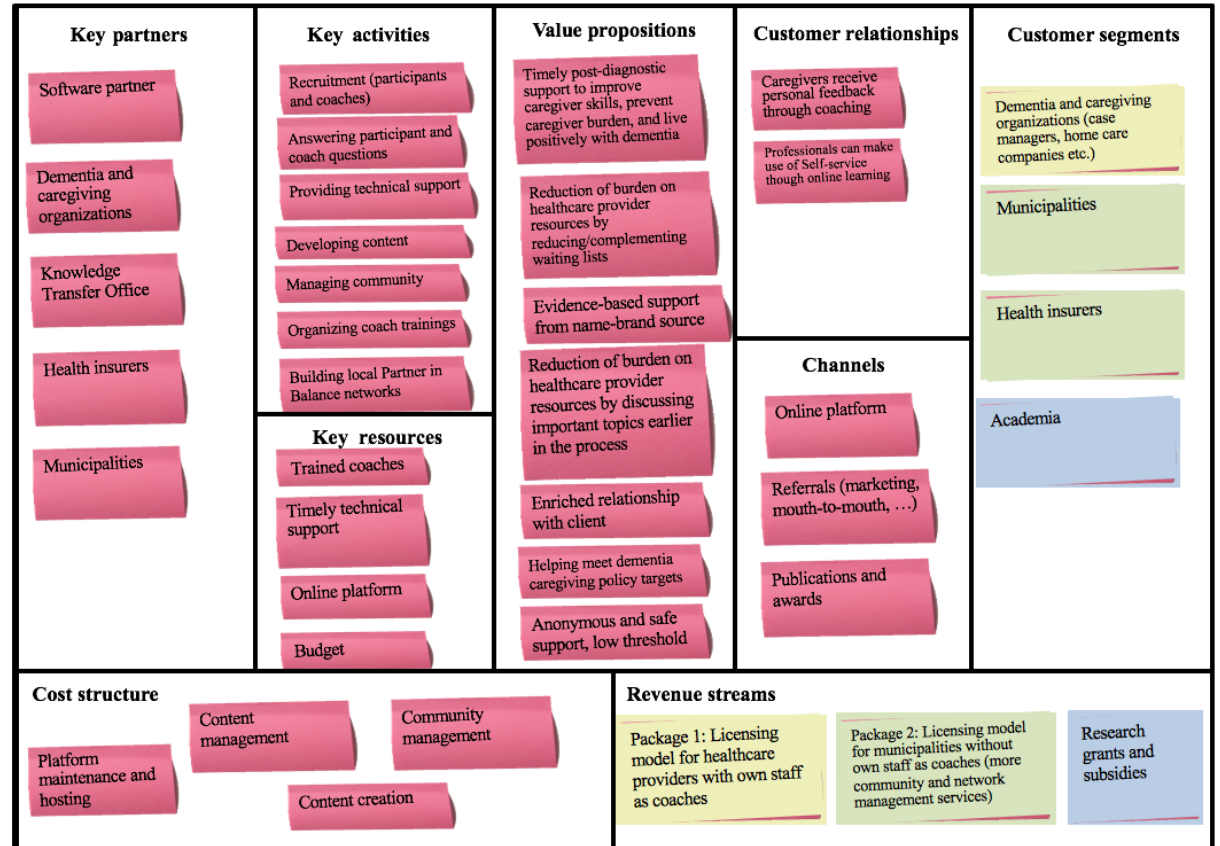
Figure 2. Partner in Balance business model canvas. The nine elements help describe a firm's or product’s structure by mapping its value proposition (middle element), infrastructure, (top left three elements), customers (top right three elements), and finances (bottom two